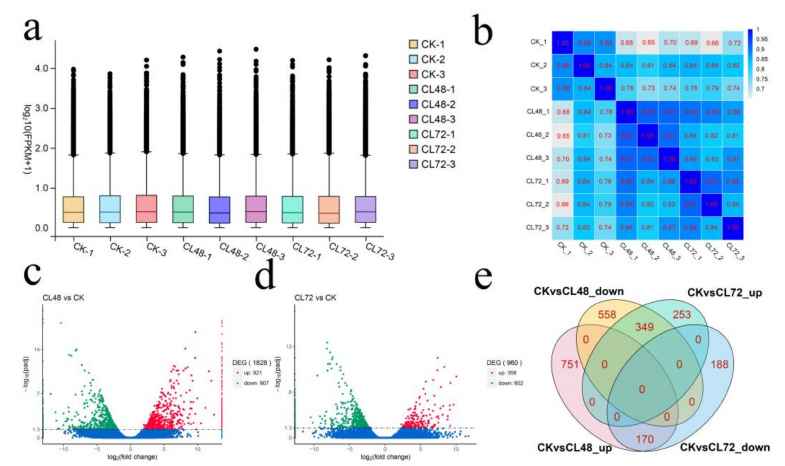
Figure 2. ( a ) Transcripts per million box plots. ( b ) Correlation analysis diagram of gene expression. ( c ) The M-versus-A (MA) plot of differentially expressed genes (DEGs) after 48 h of NaCl treatment. ( d ) The M-versus-A (MA) plot of DEGs after 72 h of NaCl treatment. ( e ) Venn diagram of all DEGs.